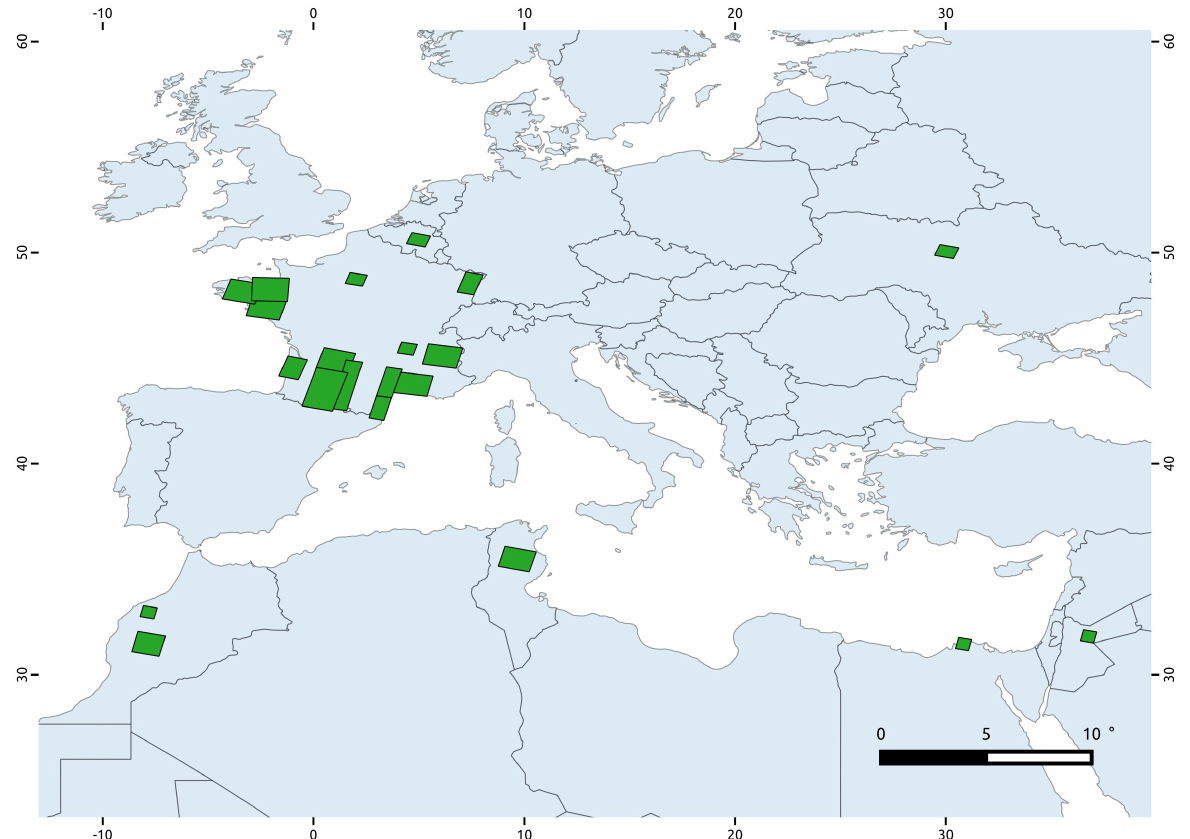
Figure 1. The green polygons show the situation of the sites in Europe and North